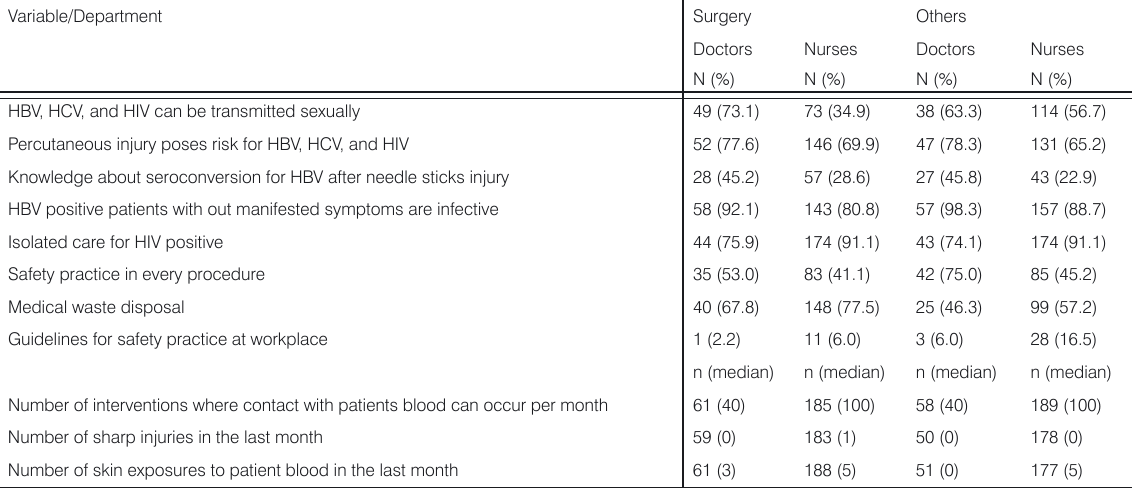
Table 2. Knowledge, attitudes and practice regarding blood-borne infection among